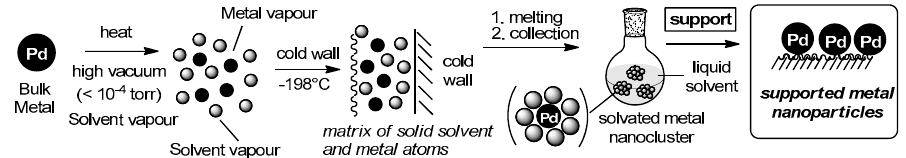
Figure 3. Schematic representation of the MVS approach to obtain supported Pd NPs.